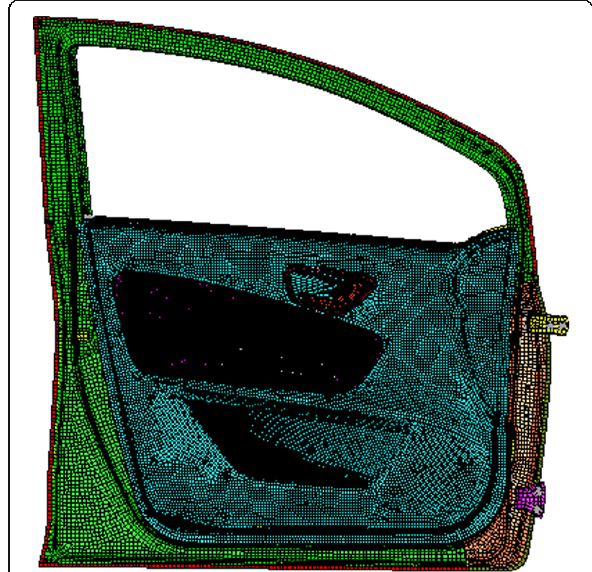
Fig. 4 The finite element model of the car door